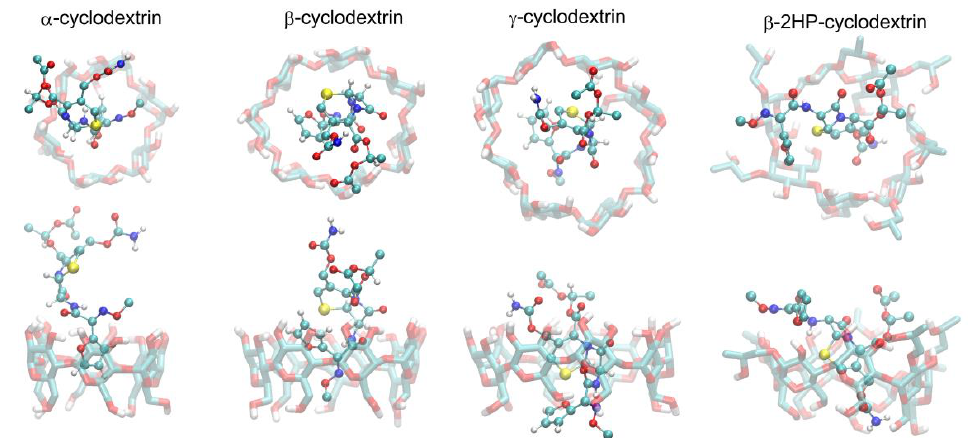
Figure 9. The MD simulation snapshots, illustrating the patterns of interactions typical for the studied complexes. Guest (CA) molecule is shown by an opaque ball-and-stick representation, while host (CD) molecule is represented by a transparent stick representation. The two views of each complex along perpendicular axes are shown.